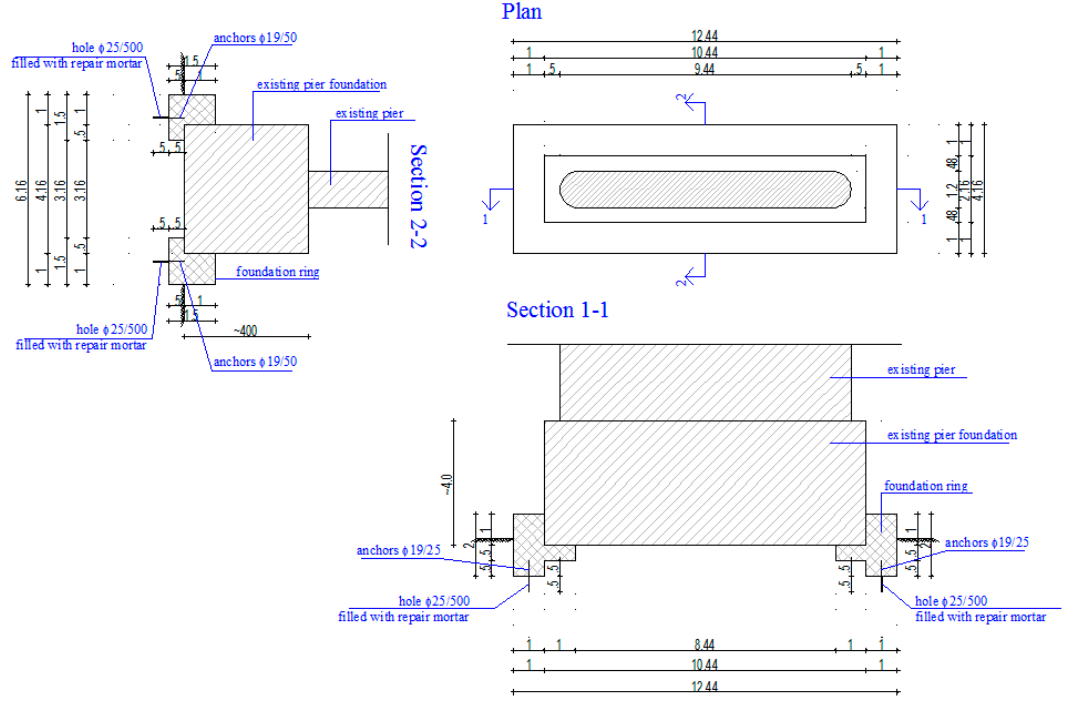
Figure 13. Strengthening of the foundation of river settled pier (units in meters).